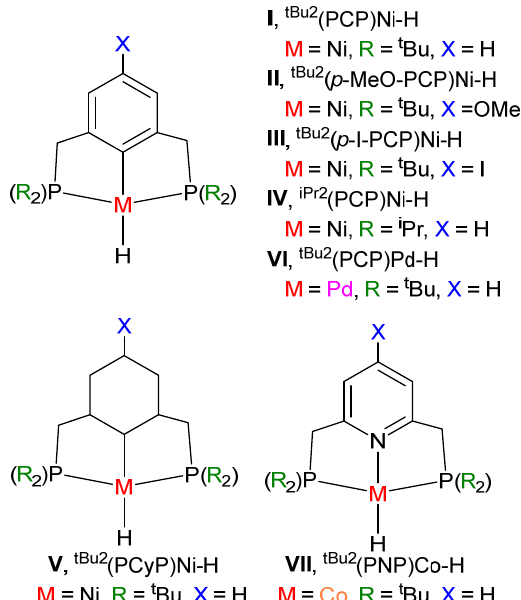
Figure 2. Studied transition metal hydride (TM–H) complexes I to VII for CO 2 insertion.